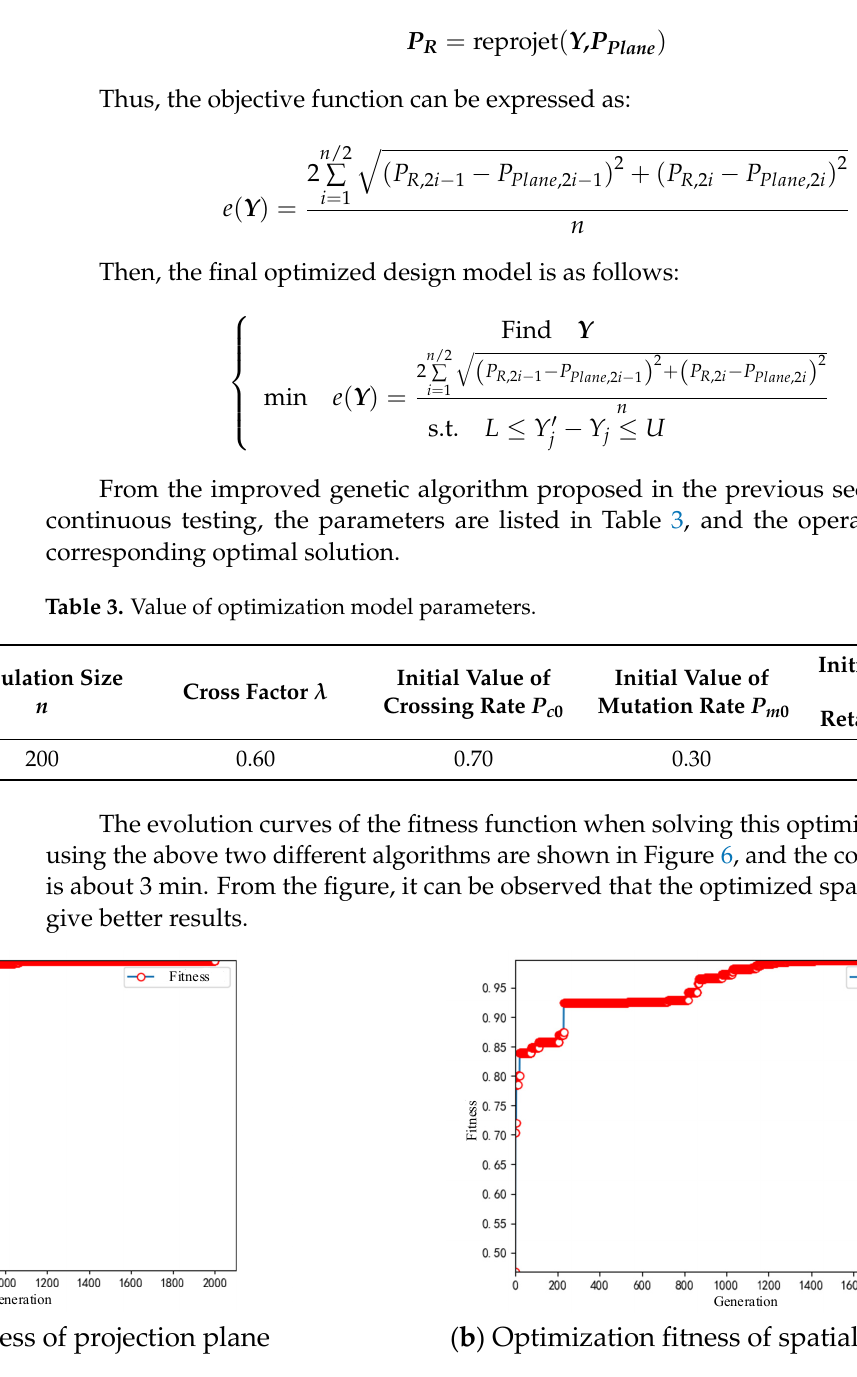
Figure 6. Comparison chart of the fitness values of the two optimization strategies. The curves show that in the initial stage of the genetic algorithm, chromosomes are relatively abundant in the population, and the two optimization strategies tend to converge in the evolutionary process about 1300 and 1200 generations later, respectively—details are listed in Table 4—and finally result in individuals with errors of 0.0091 mm and 0.0009 mm,